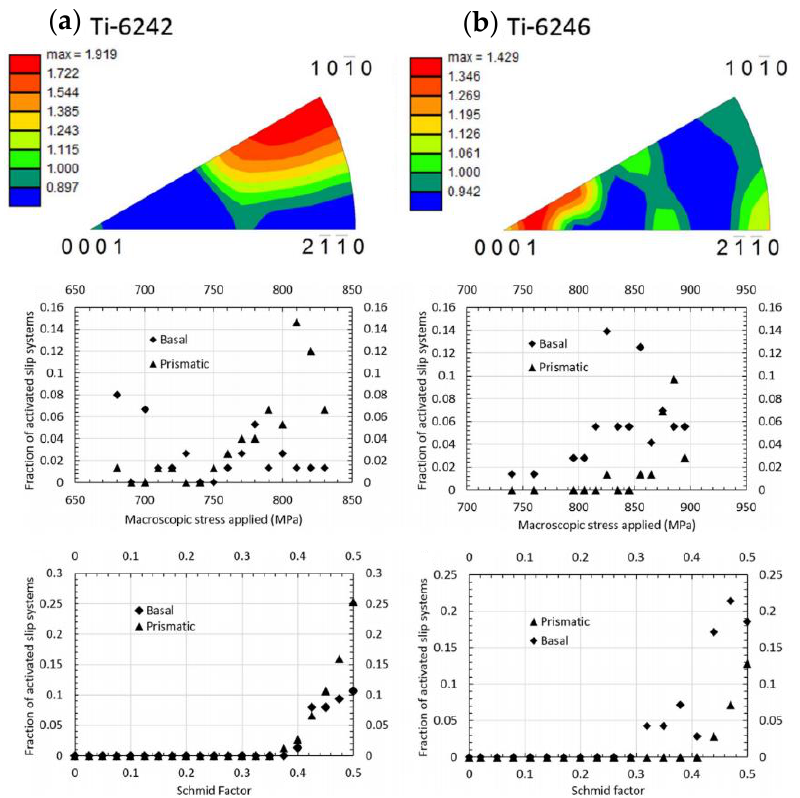
Figure 3. Slip activation of the ( a ) Ti-6242 and ( b ) Ti-6246 alloys under different stresses and different Schmid factors at 800 MPa [72].